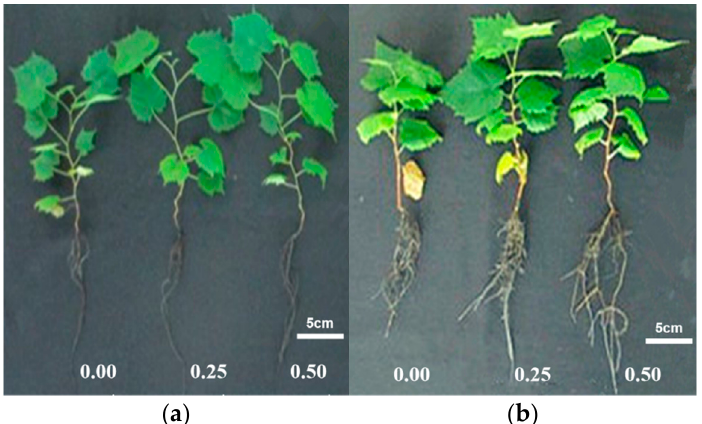
Figure 1. Growth status of two genotypes treated with 0.00, 0.25, and 0.50 mg·L − 1 B solution for 60 days: ( a ) ‘Xishui-4 ′ ; ( b ) ‘Crystal’.